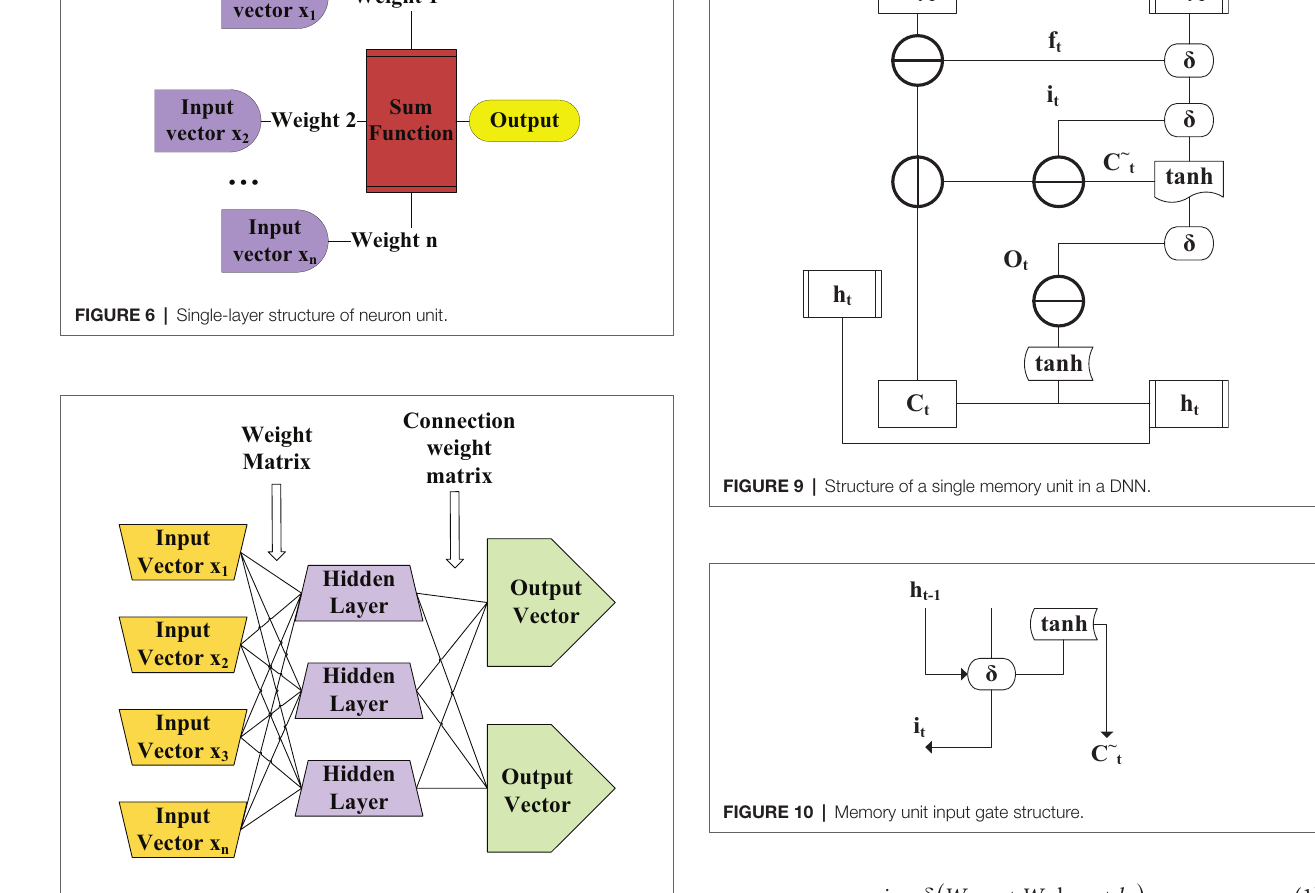
FIGURE 7 | Multilayer neuron structure diagram.